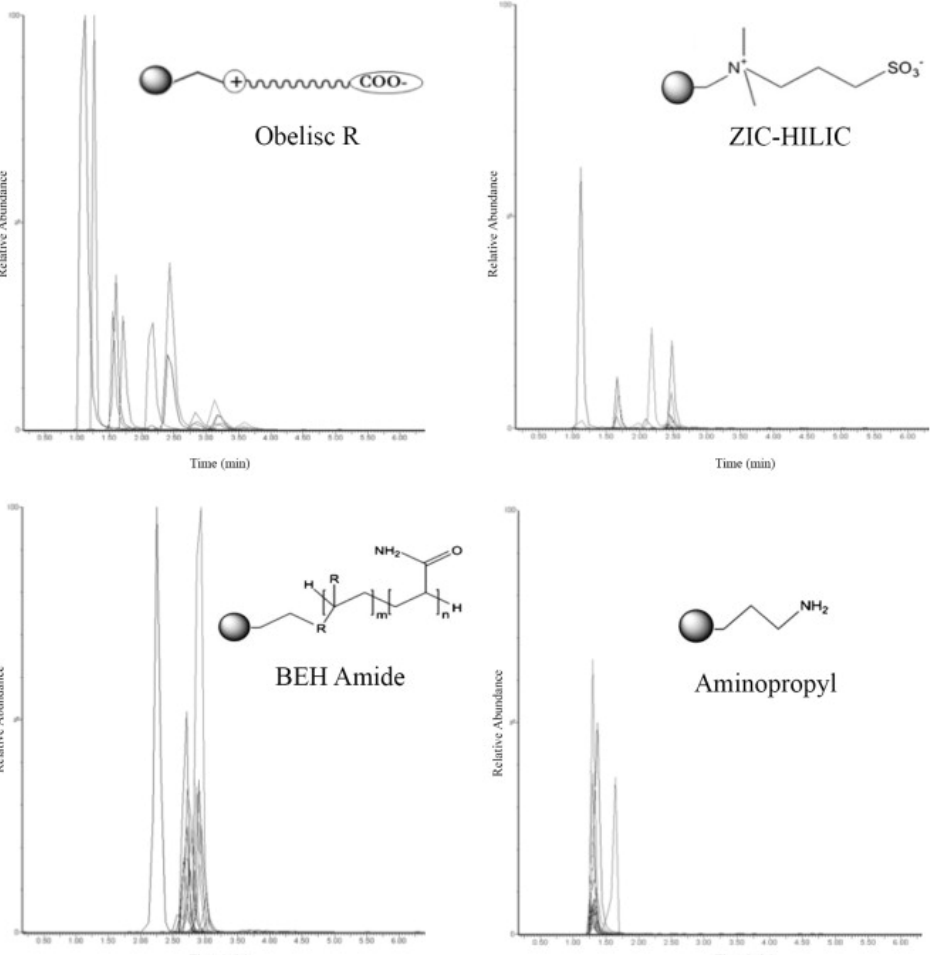
Table 1. Commercial stationary phases (in alphabetical order) . Phase Type